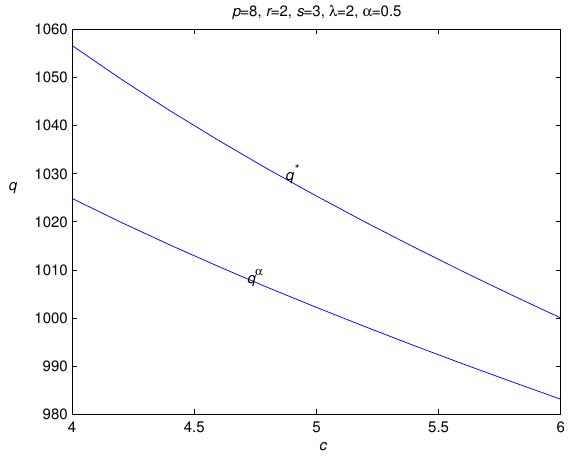
Figure 1. Optimal order quantities q ∗ and q α with different retail prices p .